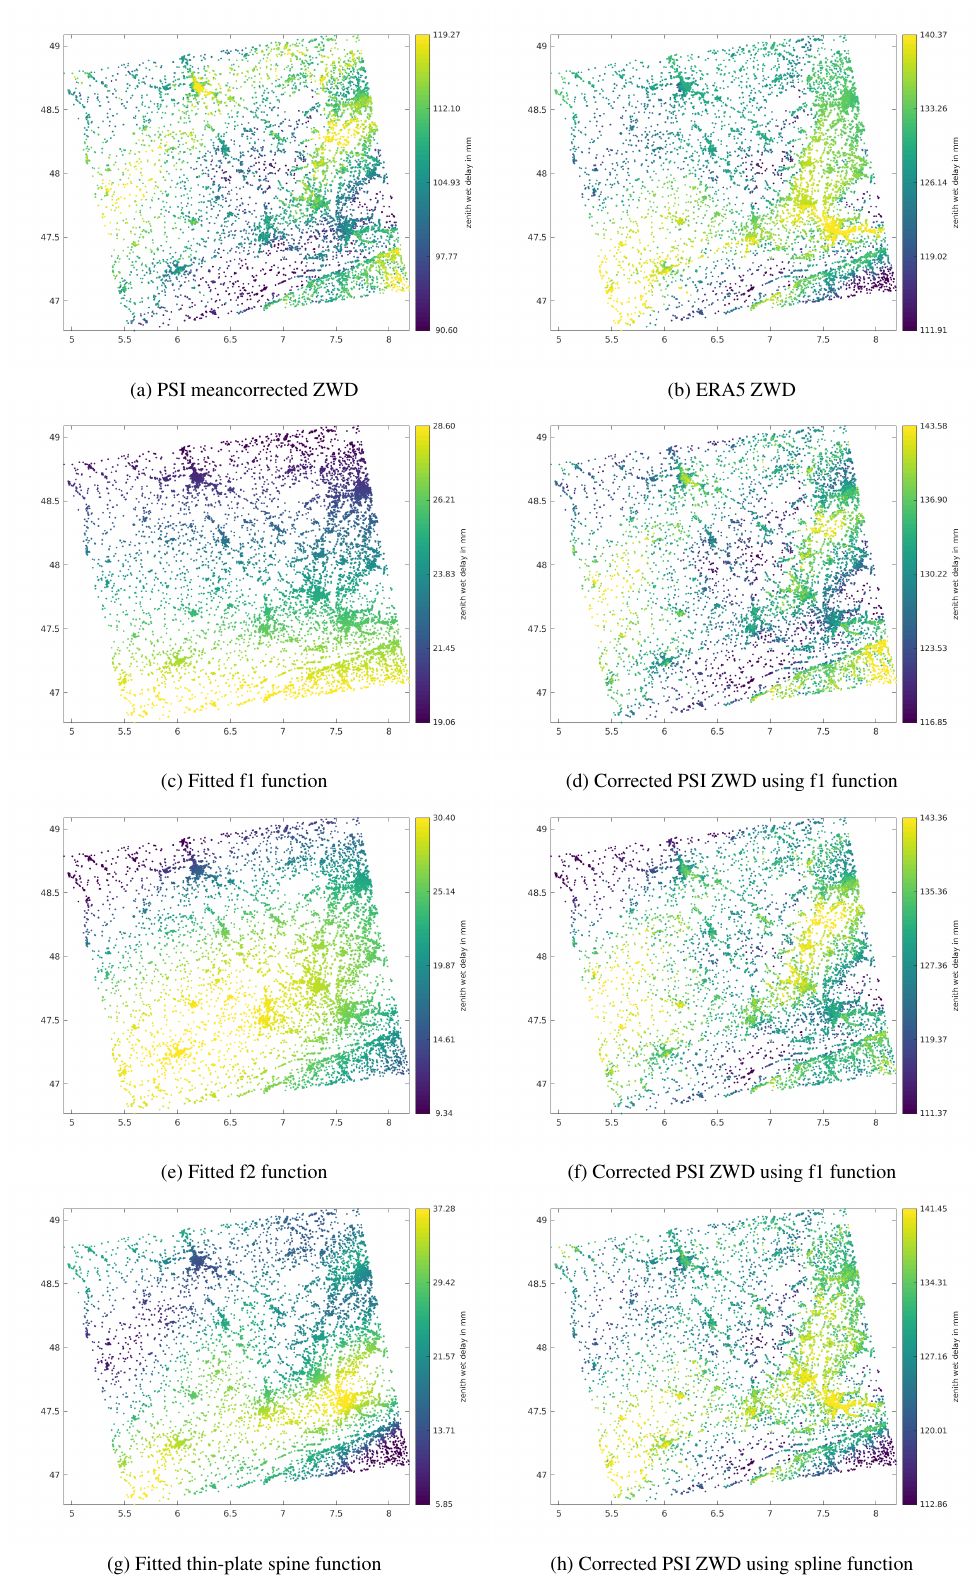
Figure 3. The example shows the dataset of 2017/11/24 17:24UTC. The top row displays the meancorrected PSI ZWD and the ERA5 ZWD. c,e,g show different correction function calculated next to the resulting corrected PSI